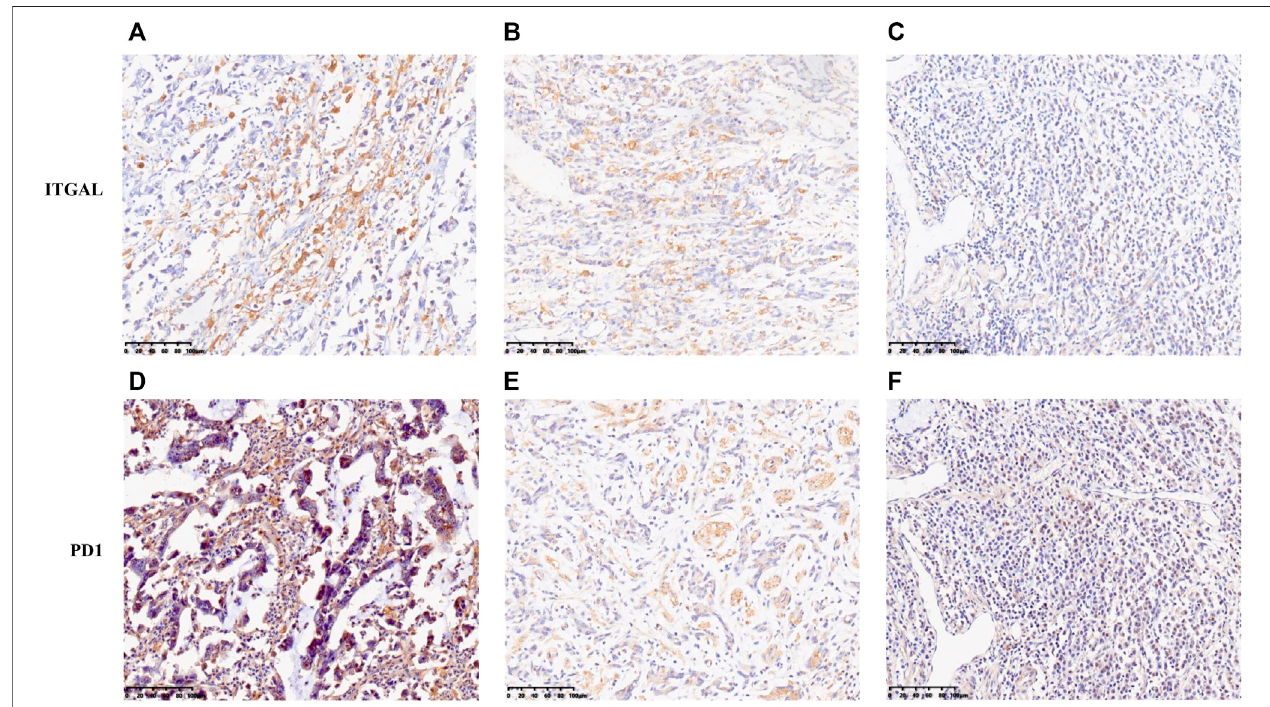
FIGURE 8 | Correlation between ITGAL expression and immune in fi ltration levers of T-cell exhaustion in gastric cancer. The expression of ITGAL [ (A) +++, (B) ++, (C) +]. The expression of PD1 [ (D) +++, (E) ++, (F) +]. The expression density of ITGAL and PD1 in gastric cancer tissue was quantitated by scoring staining intensity, including negative ( − ) and weak (+) staining, moderate (++) and strong (+ + +) staining, respectively.